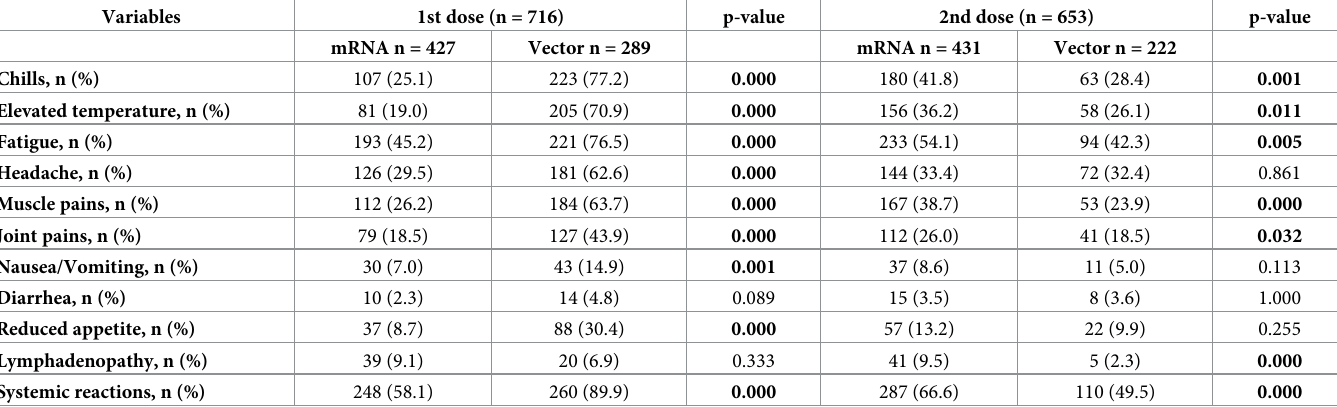
Table 3. Systemic reactions after first and second dose with mRNA and adenoviral vector vaccines.